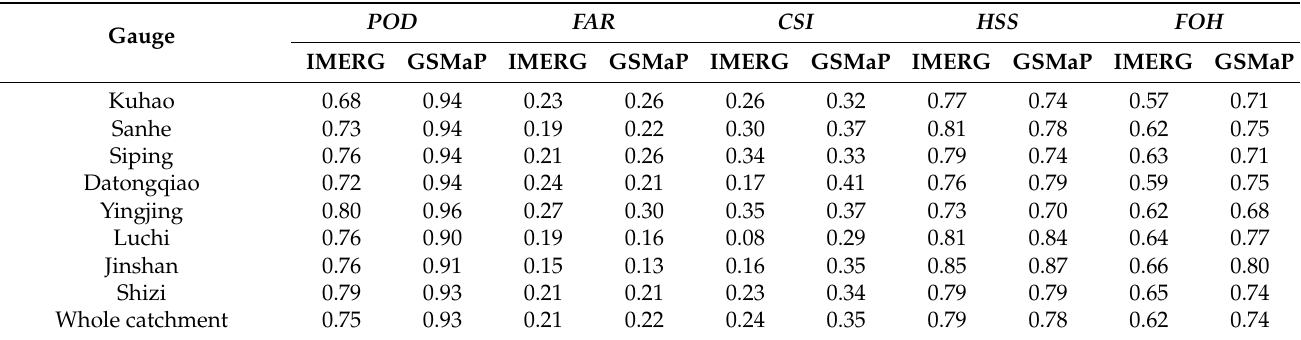
Figure 4. Rainfall event detective ability of IMERG and GSMaP products. Table 5. Summary of rainfall detective ability evaluation of IMERG and GSMaP products at daily